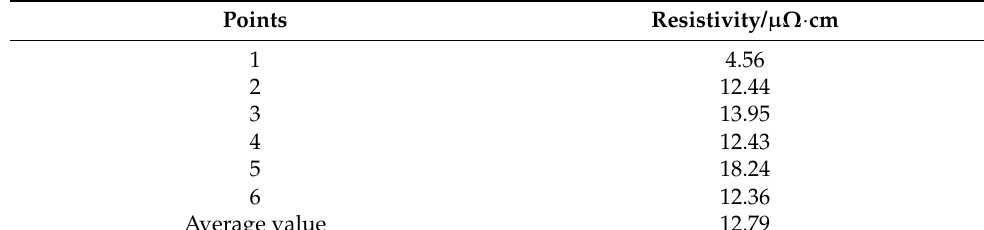
Figure 11. Surface roughness test results: ( a ) small roughness area; ( b )large roughness area. Table 3. Resistivity test results.